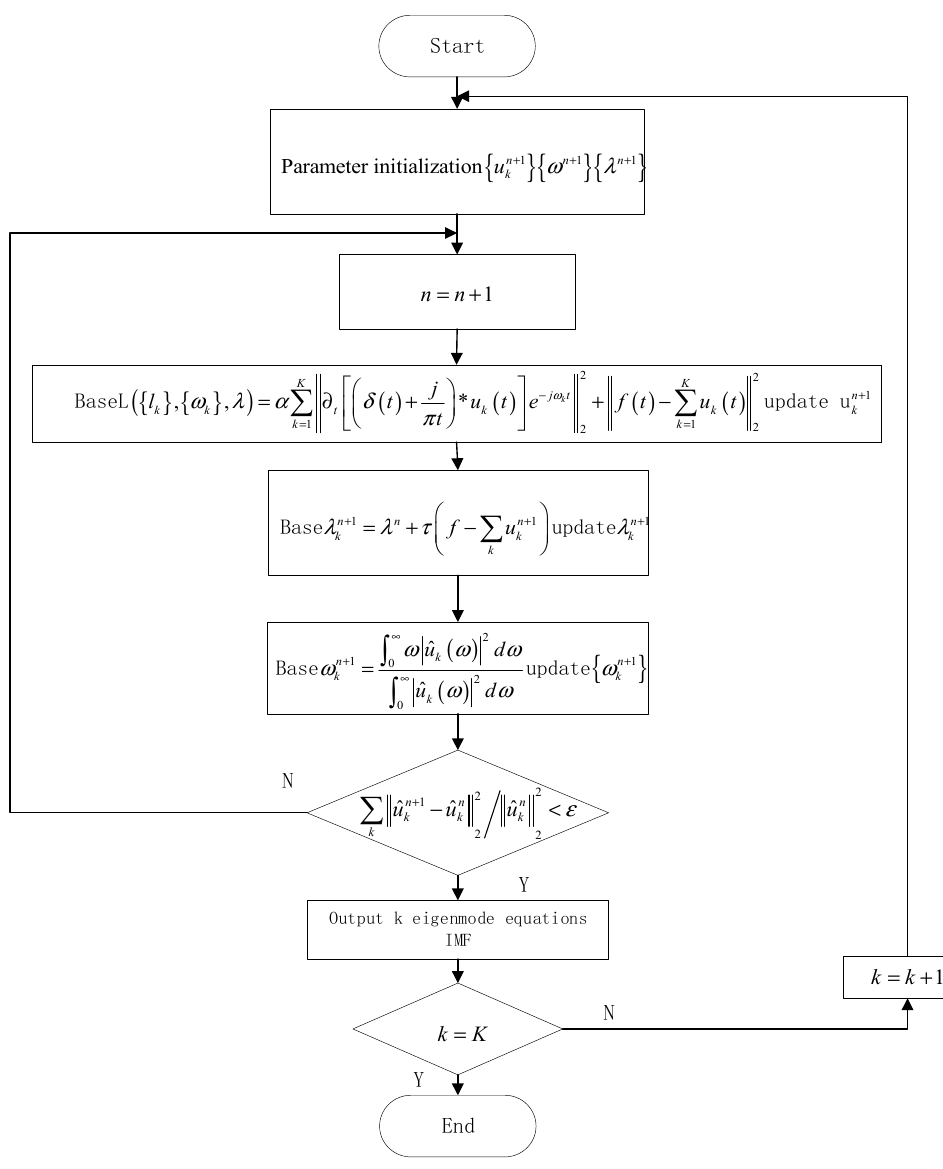
Figure 1. Variational Modal Decomposition Process.